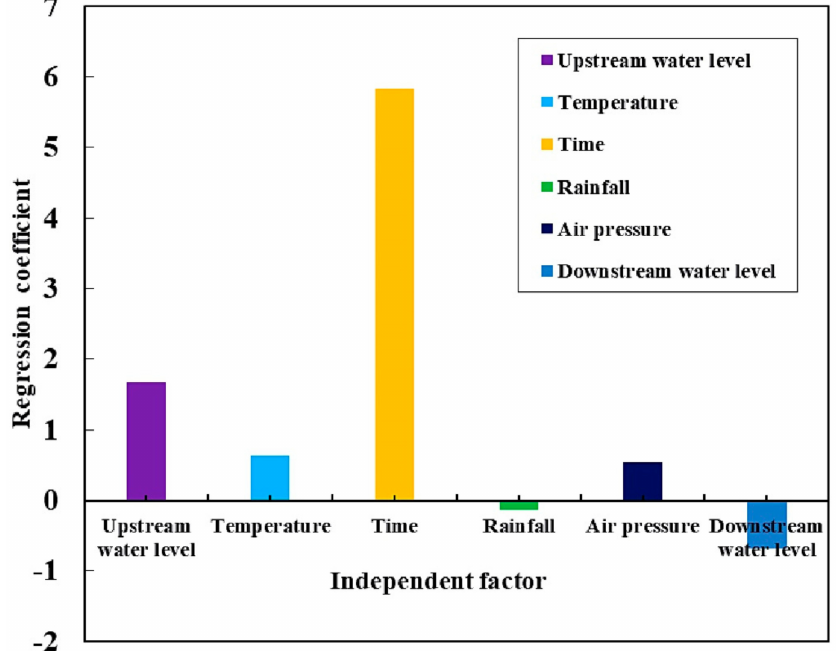
Figure 7. Histogram of regression coe ffi cients. The coe ffi cient value of time divided by